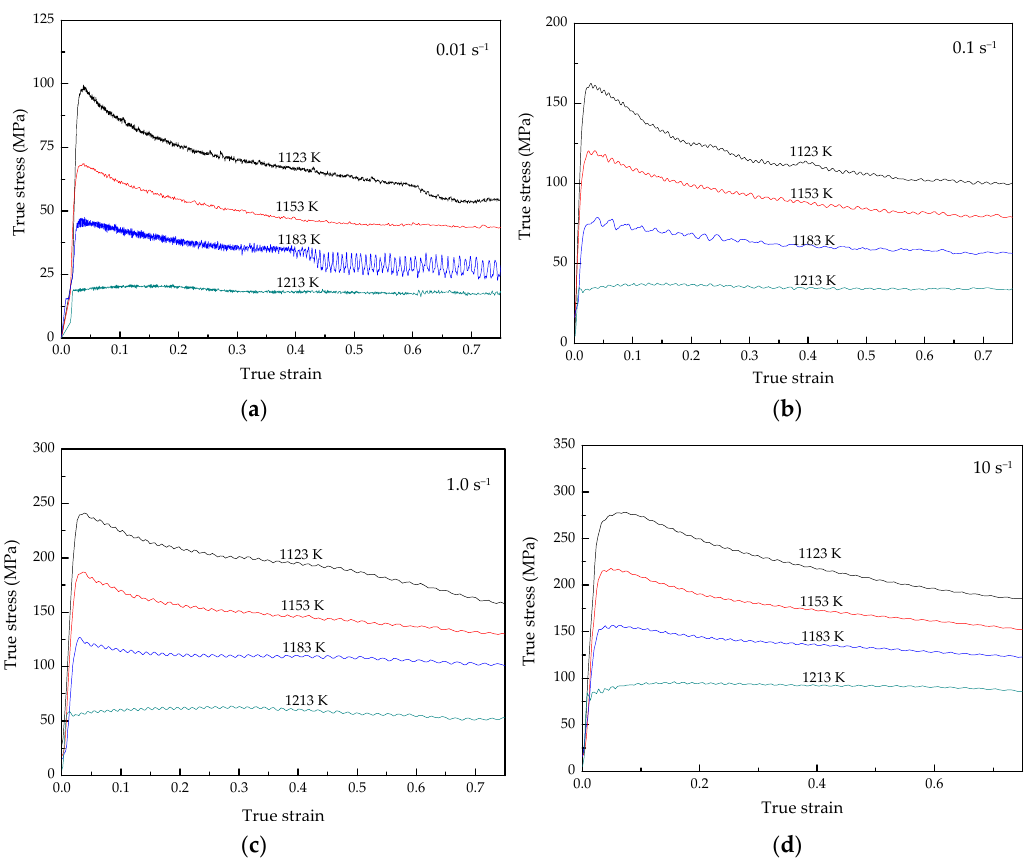
Figure 4. Flow stress–strain curves of Ti–3.3Al–1.5Zr–1.2Mo–0.6Ni titanium alloy at different strain rates: ( a ) 0.01 s − 1 , ( b ) 0.1 s − 1 , ( c ) 1.0 s − 1 , and ( d ) 10 s − 1 .